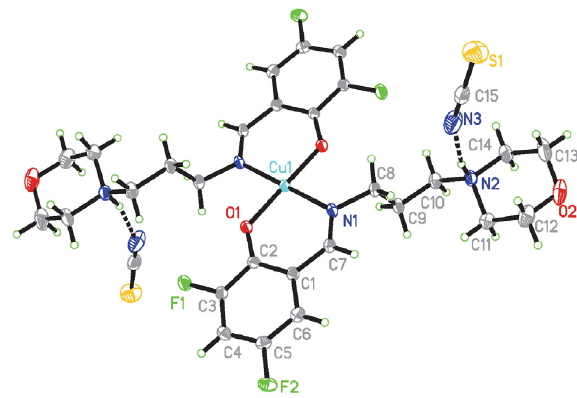
Figure 7. A perspective view of complex 4 with the atom labeling scheme. Thermal ellipsoids are drawn at the 30% probability le-